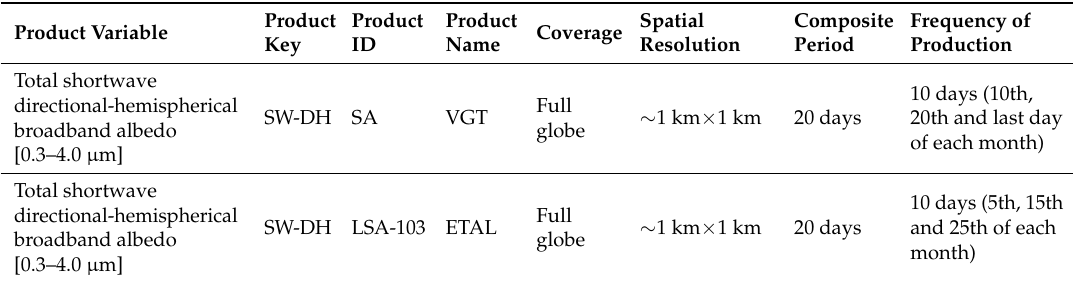
Table 2. SPOT-VGT Copernicus Climate Change Service (VGT-C3S)-based Ten-day and Land Surface Albedo (ETAL) surface albedo product